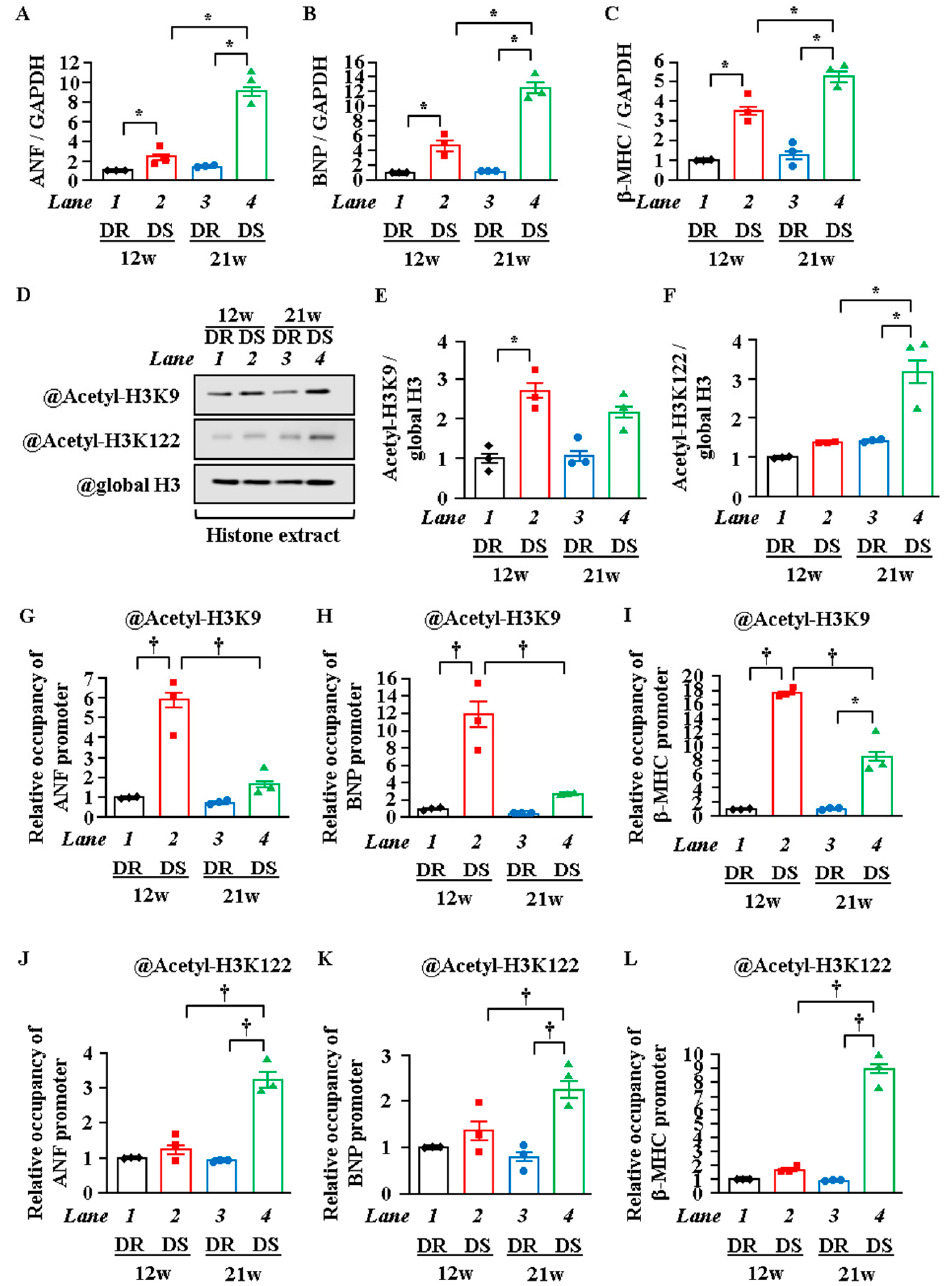
Figure 4. H3K9 acetylation was increased at the LVH stage, but H3K122 acetylation was increased at the HF stage. At 6 weeks of age, male Dahl salt-sensitive (DS) and salt-resistant (DR) rats were given an 8% NaCl diet for the following 6 or 15 weeks. Using echocardiography, left ventricular hypertrophy (LVH) stage was confirmed at 12 weeks of age, and heart failure (HF) stage was confirmed at 21 weeks of age. ( A – C ) mRNA was extracted from the hearts of DR and DS rats at 12 or 21 weeks of age, and mRNA levels of ANF ( A ), BNP ( B ), and β -MHC ( C ) were measured. ( D – F ) Nuclear proteins and histone fraction were extracted from the hearts of DR and DS rats at 12 or 21 weeks of age. ( D ) is a photograph of a representative Western blot, and ( E , F ) are quantifications ( D ). ( G – L ) In vivo ChIP assay was performed using heart lysates of DR and DS rats at 12 or 21 weeks of age with anti-acetyl-histone H3K9 antibody ( G – I ), anti-acetyl-histone H3K122 antibody ( J – L ), or normal rabbit IgG as a negative control (not detected). ( A – C and E – L ), N = 3; two-way ANOVA followed by Tukey test. * p < 0.05, † p < 0.01. 2.5. Interaction Between P300 and BRG1 Was Enhanced, and The Recruitment of BRG1 Was Increased in Heart Failure The above experiments demonstrated that the increase in transcription that occurs with the transition from the LVH stage to the HF stage is associated with differences in the site of histone acetylation during each stage. To investigate whether the change in recruitment of p300 onto the reactive gene promoters affects this change in the histone acetylation domain, an in vivo ChIP assay was performed. The results showed that the